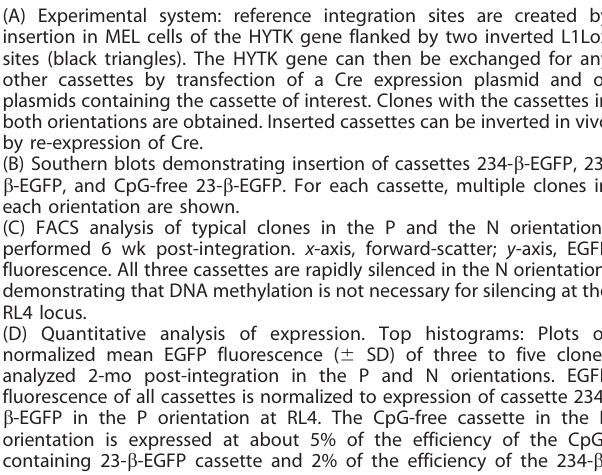
Figure 1. DNA Methylation Is Not Necessary for